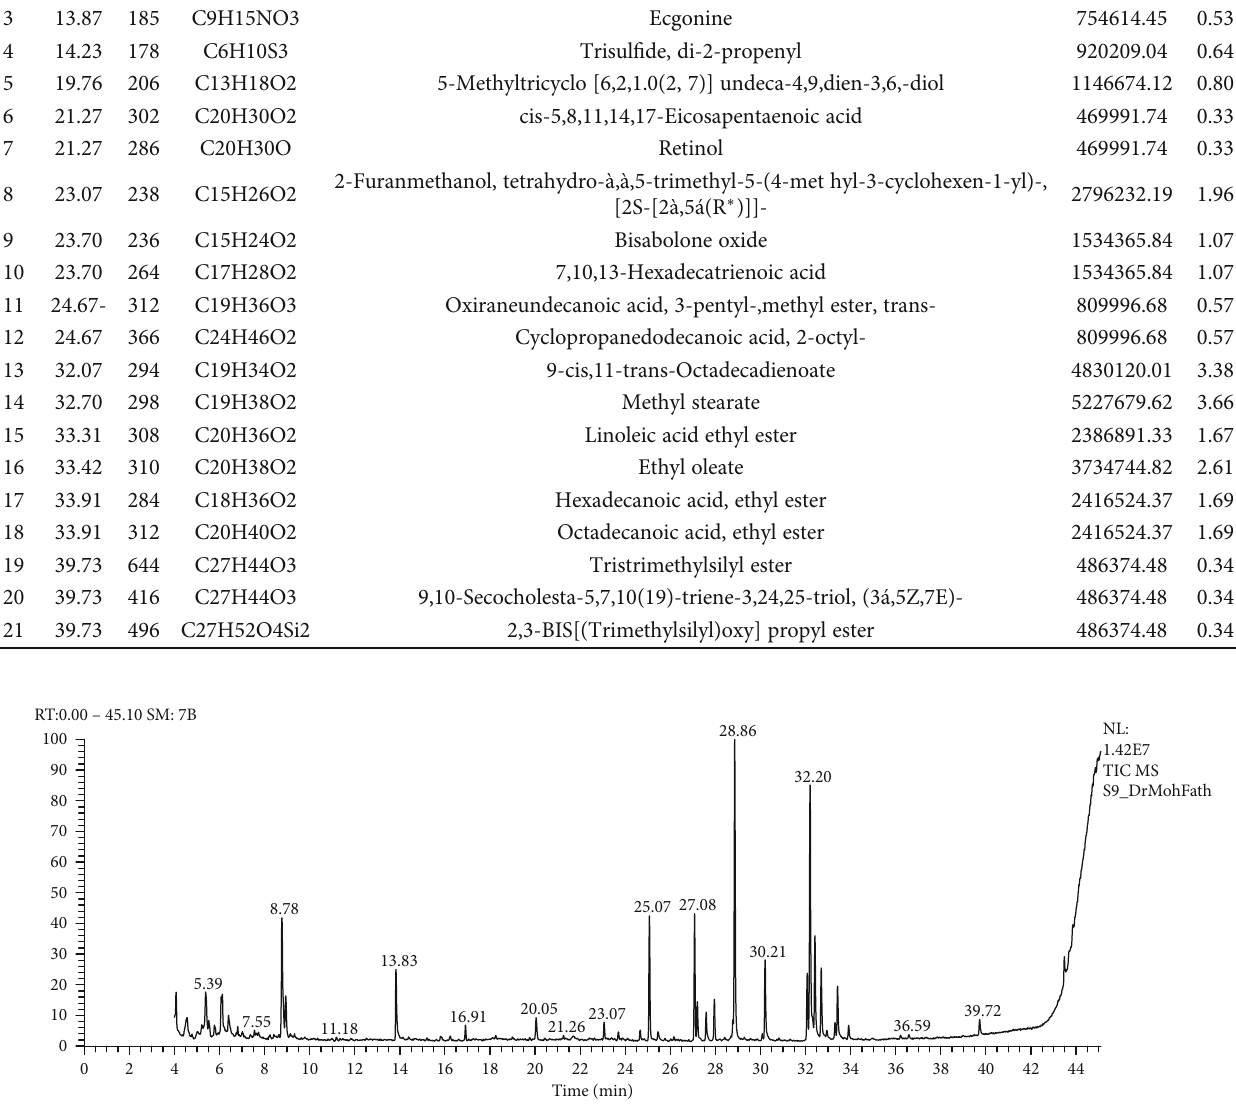
Figure 2: GC-MS chromatogram of aqueous plant extract of Piper nigrum